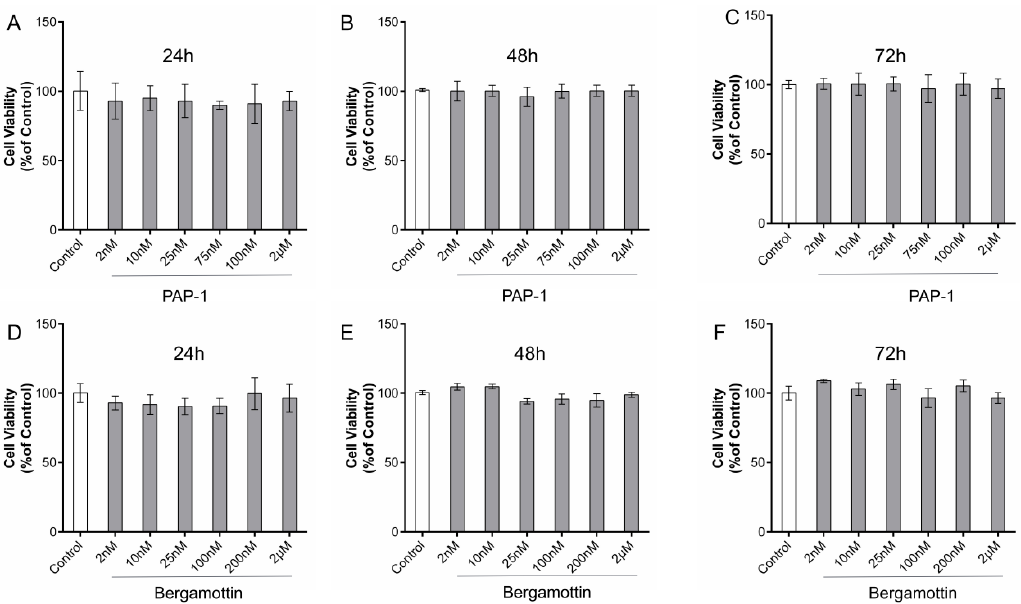
Figure 7. Effects of PAP-1 and bergamottin on viability of AT-II cells (CCK-8 assay). ( A – C ) Effects on viability of AT-II cells stimulated with PAP-1 for 24, 48, and 72 h. ( D – F ) Effects on viability of AT-II cells stimulated with bergamottin for 24, 48, and 72 h. Data are presented as mean ± SD, n = 3 (three separate experiments).